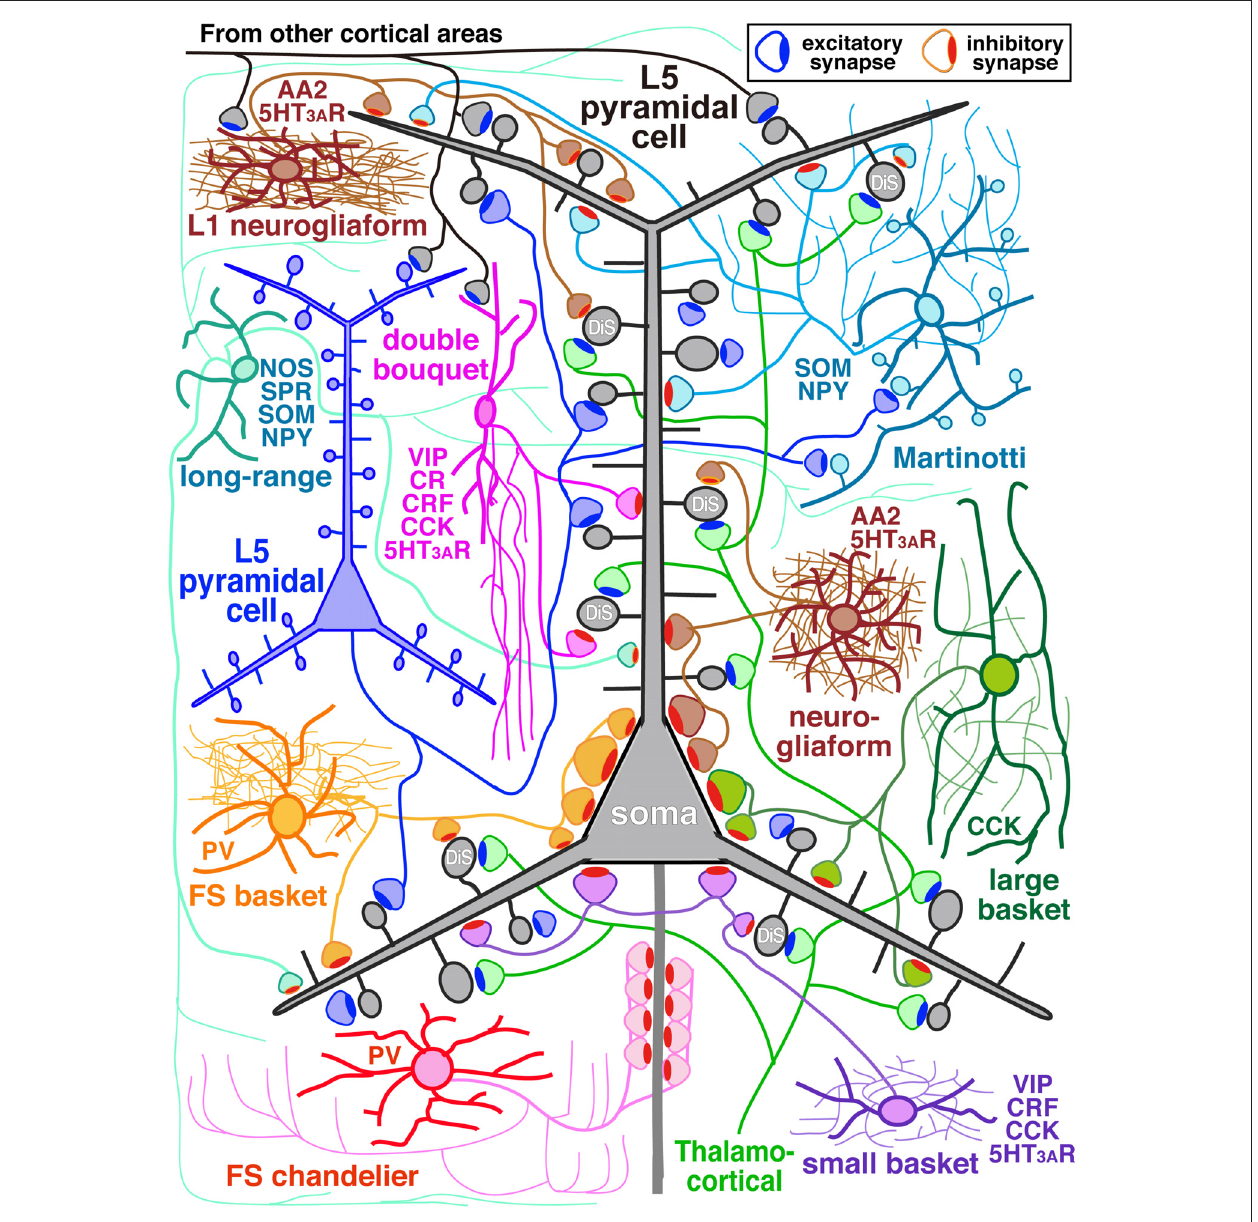
FIGURE 1 | Diagram of cortical microcircuit showing the major subtypes of GABAergic inhibitory interneurons and their synaptic diversity. DiS, dually innervated spine; L5, layer V; AA2, alpha actinin 2; CCK, cholecystokinin; CR, calretinin; CRF, corticotrophin releasing factor; NOS, nitric oxide synthase; NPY, neuropeptide Y; PV, parvalbumin; SOM, somatostatin; SPR, substance P receptor; VIP, vasoactive intestinal polypeptide; 5HT 3A R, 5-HT 3A receptor.